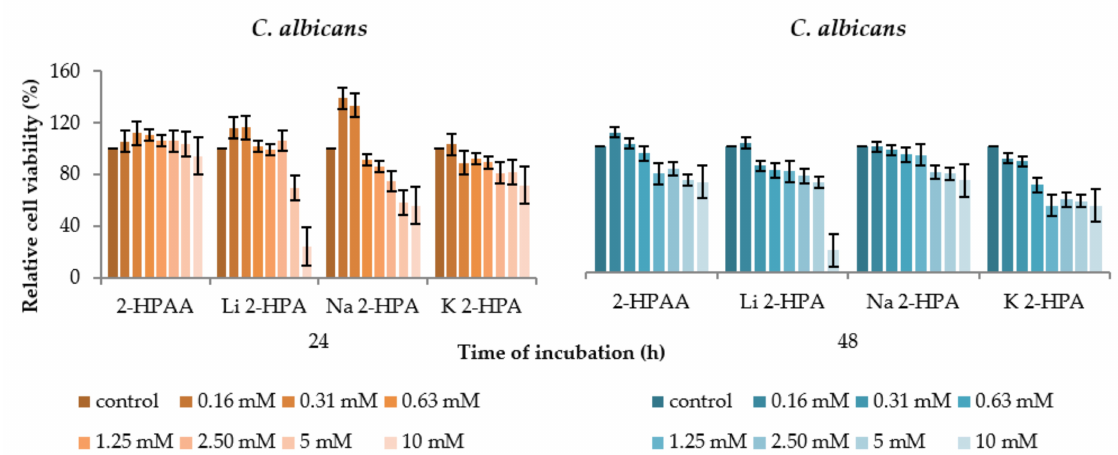
Figure 10. Cytotoxicity of 2-HPAA and its alkali metal salts with Li, Na, and K on bacteria ( E. coli , K. aerogenes , B. subtilis , and P. fluorescens ) and fungal ( C. albicans ) strains expressed as relative cell viability (%) compared to the control sample (untreated cells—100%).